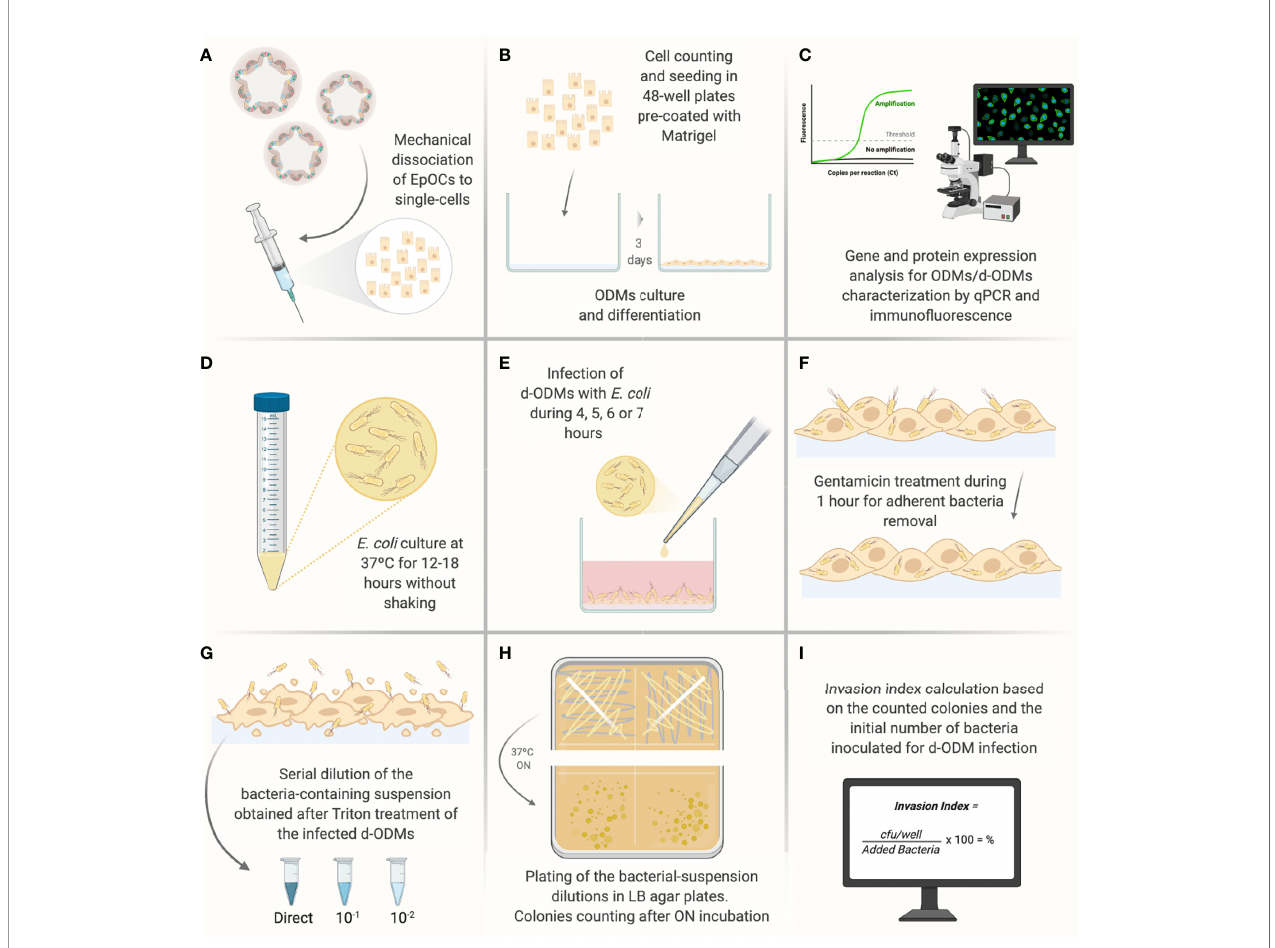
FIGURE 1 | Illustrated experimental work fl ow of the most critical steps of the d-ODMs- E. coli infection protocol. (A) Mechanical dissociation of EpOCs with the help of a 5 ml syringe with a 21G needle until achievement of single-cells. (B) Single-cell counting and seeding (2x10 5 cells/well on pre-coated 48-well plates with diluted Matrigel (1:20). Cells were incubated until ODM formation for further differentiation. (C) Characterization of ODMs and d-ODMs by qPCR and immunostaining (only during the protocol set-up). (D) ON growth of E . coli LF82 and K12 strains were grown in liquid LB. (E) Infection of d-ODMs with E . coli strains performed by gently releasing the drop. Infection times were from 4-7 hours. (F) Gentamicin (100 µg/ml) addition for 1 hour to eliminate adherent bacteria. (G) Cell treatment with 1% Triton X-100 to facilitate intracellular bacteria release. The bacterial suspension was then serially diluted and seeded. (H) ON incubation of bacterial dilutions in LB agar plates. (I) After colony counting, the Invasion Index for each strain was determined. This fi gure was created using